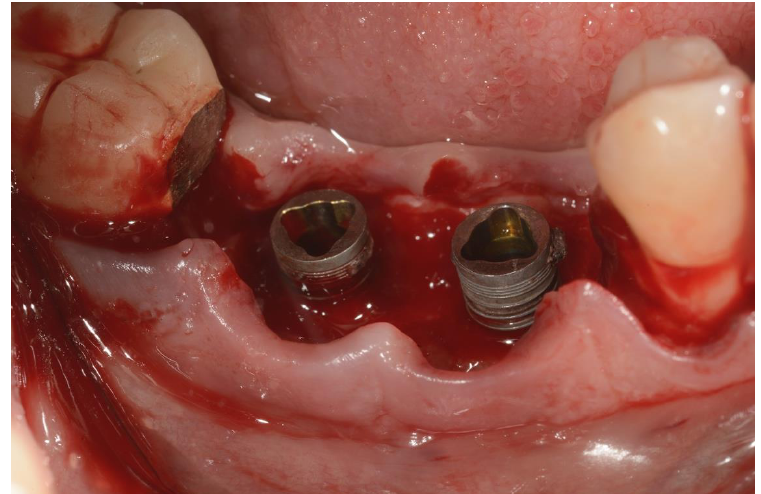
Figure 3. Surgical area after incision and flap elevation.